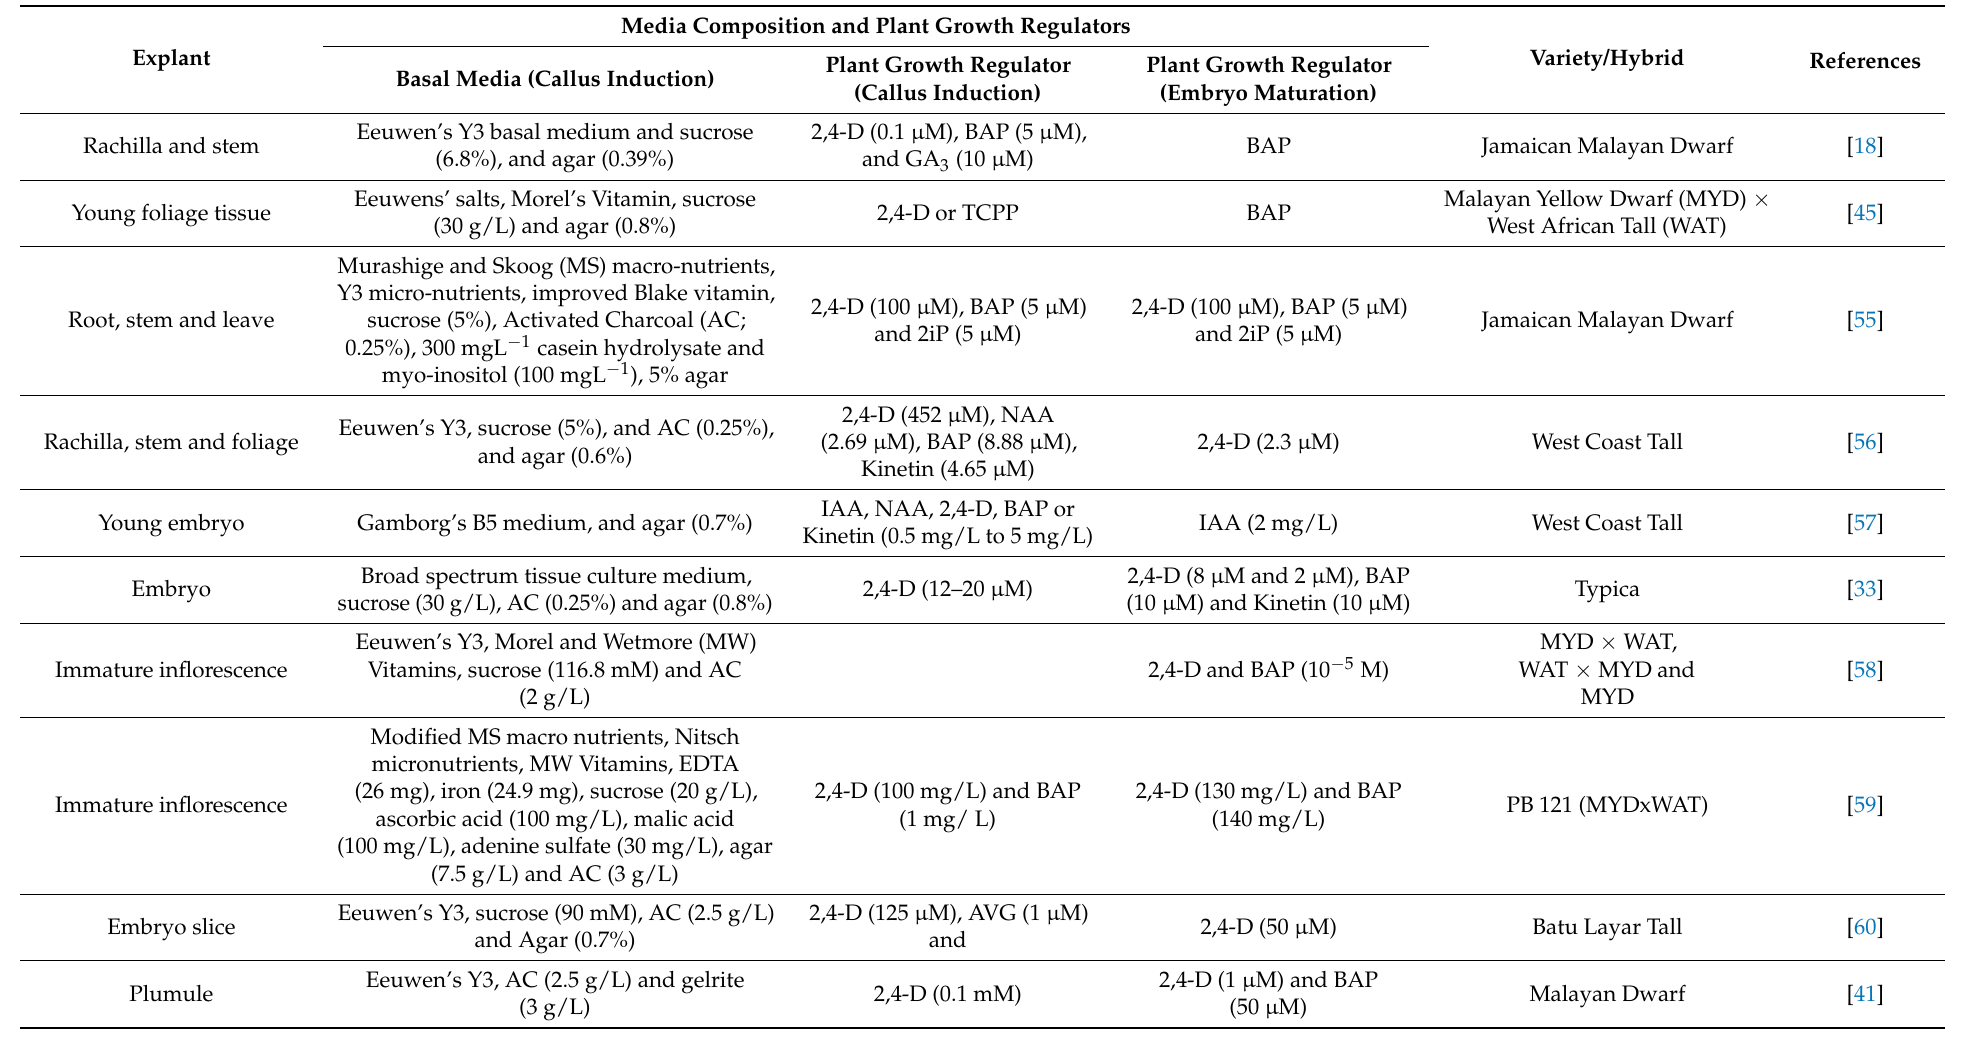
Table 1. In vitro studies on explant, media composition, and plant growth regulators in order from older to recent studies in